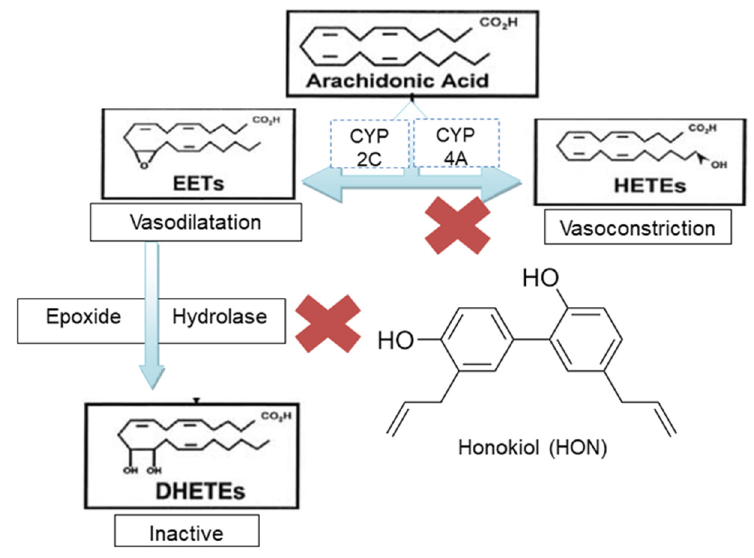
Figure 1. Metabolism of arachidonic acid by cytochrome P450 (CYP) enzymes and soluble epoxide hydrolase (sEH). The sign “x” indicates the proposed sites for the antihypertensive effect of HON.